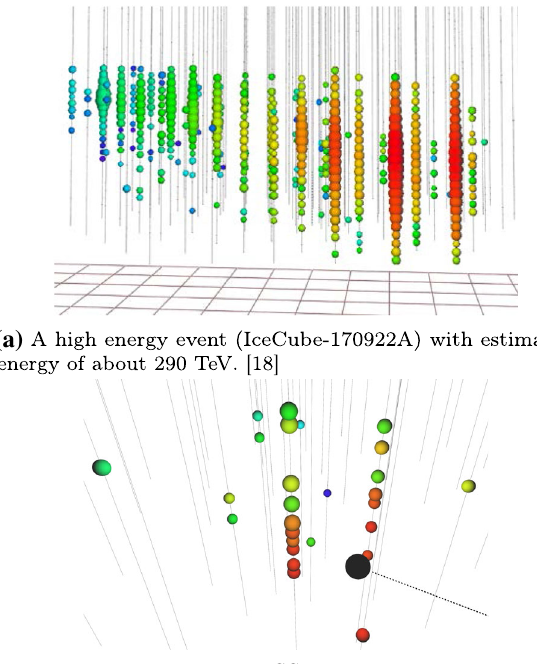
individual single photo electrons (SPEs) [22] from the raw data, resulting in a collection of pulses, t i , with charges q i